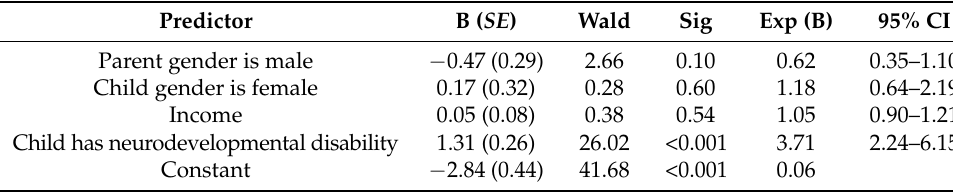
Table 3. Logistic regression analysis of Auskick season completion.